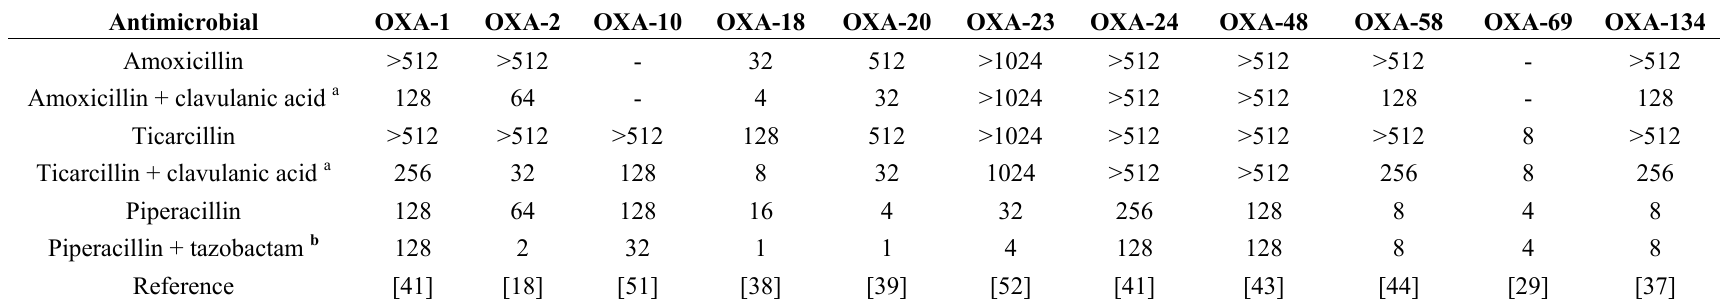
Table 5. MICs for penicillins in the presence and absence of inhibitors against diverse enzymes.